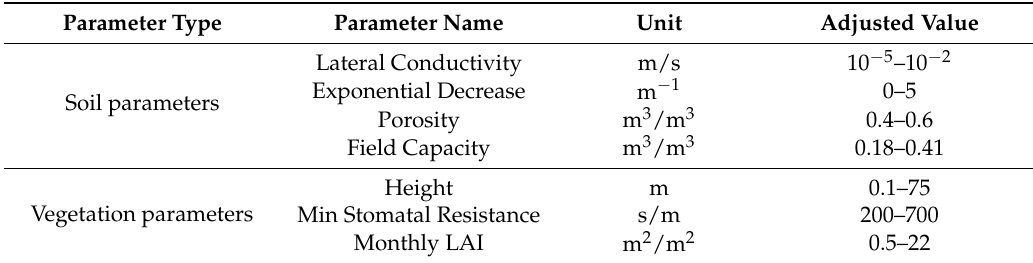
Table 2. The parameters of